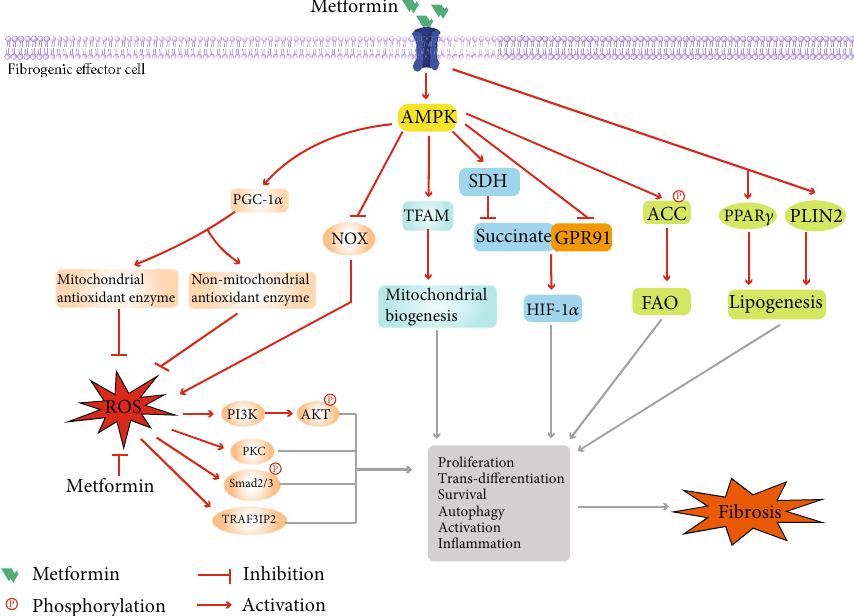
Figure 3: The other potential mechanisms of metformin in anti fi